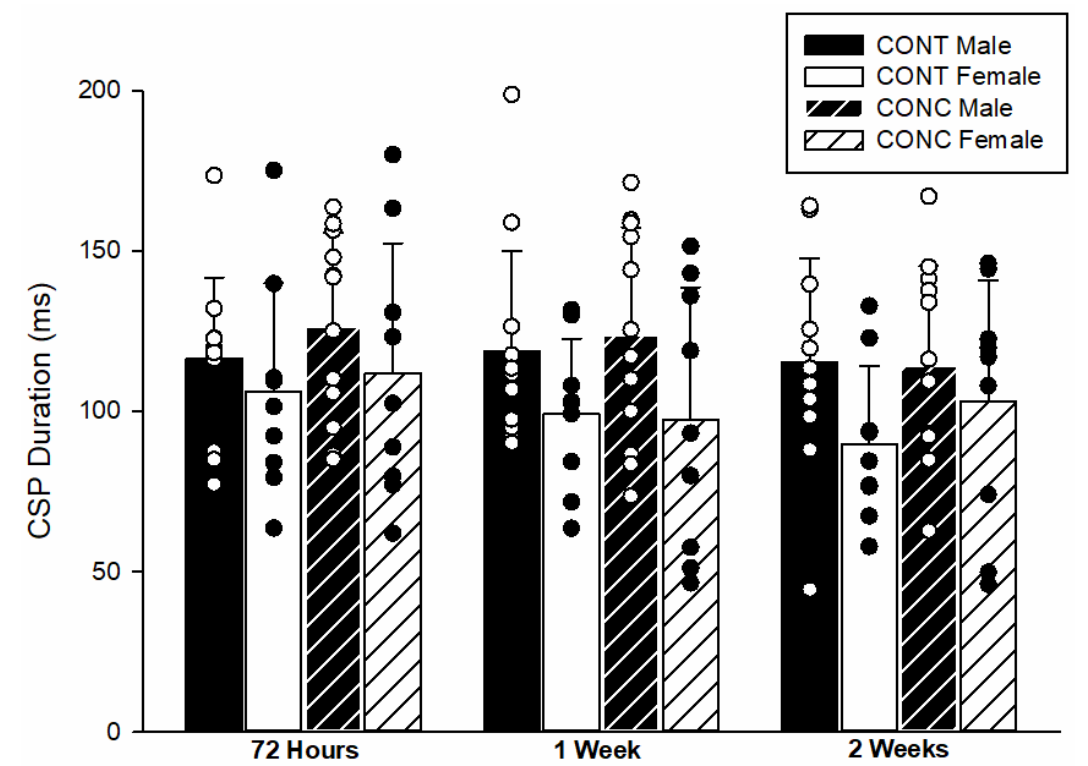
Figure 3. CSP duration across the two-week testing period. The CSP duration was similar between groups ( p = 0.54) across all time points. Overall, males had significantly longer CSP durations than females ( p = 0.04). Circles represent individual data points.